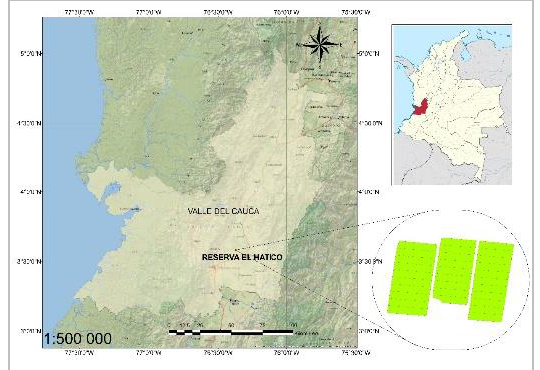
Figure 1. Location of experimental crop (758B)